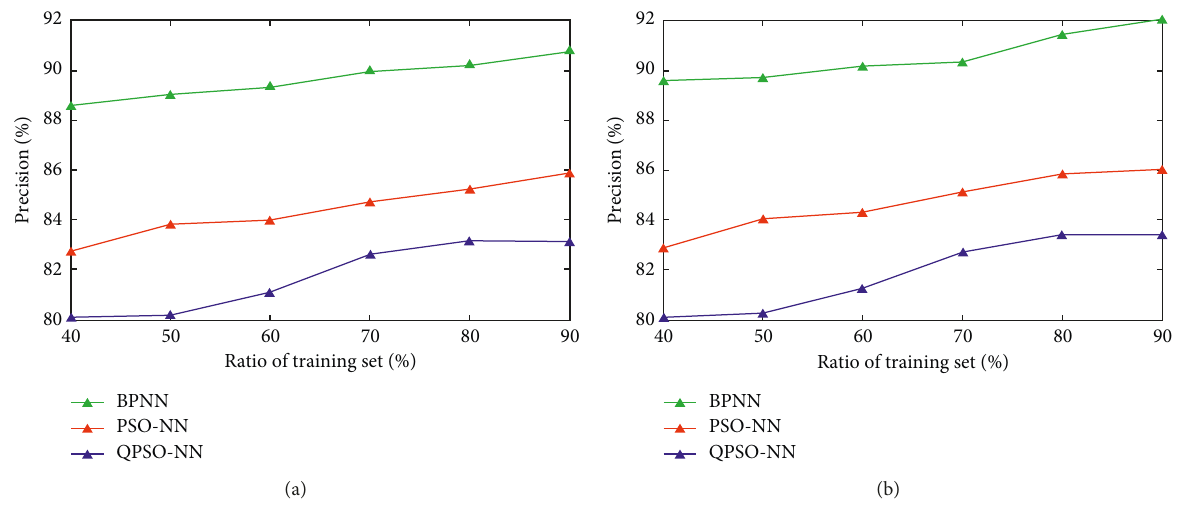
Figure 10: The impact on precision caused by ratio of training set. (a) Population size � 60; (b) population size � 80.